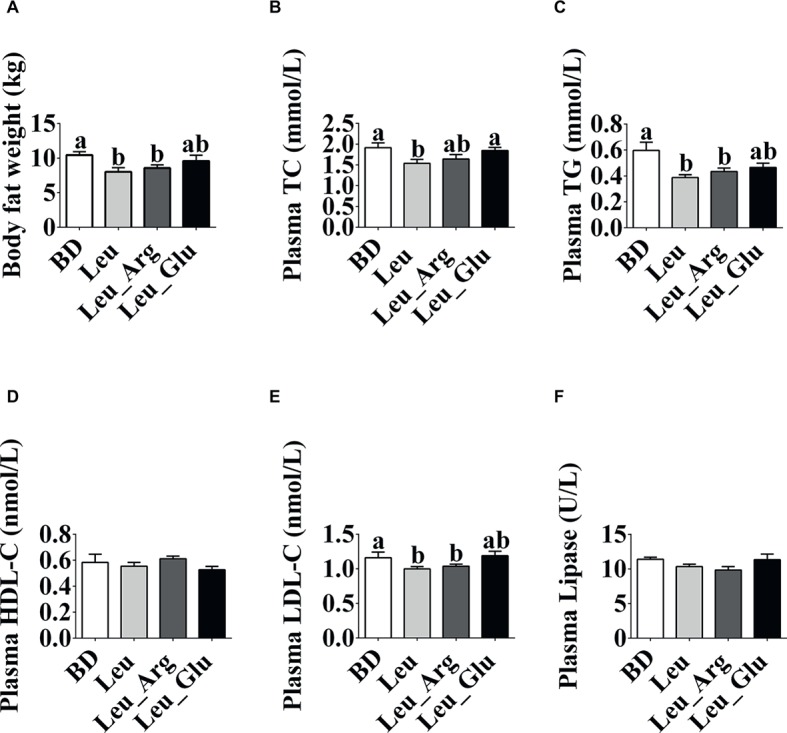
Phenotype changes under dietary Leu, Arg, and Glu treatment. (A) Body fat weight. (B-F) Plasma TC, TG, HDL-C, LDL-C, and lipase concentrations. Data represent the means ± SEM. a,bindicate statistically significant differences (p < 0.05).